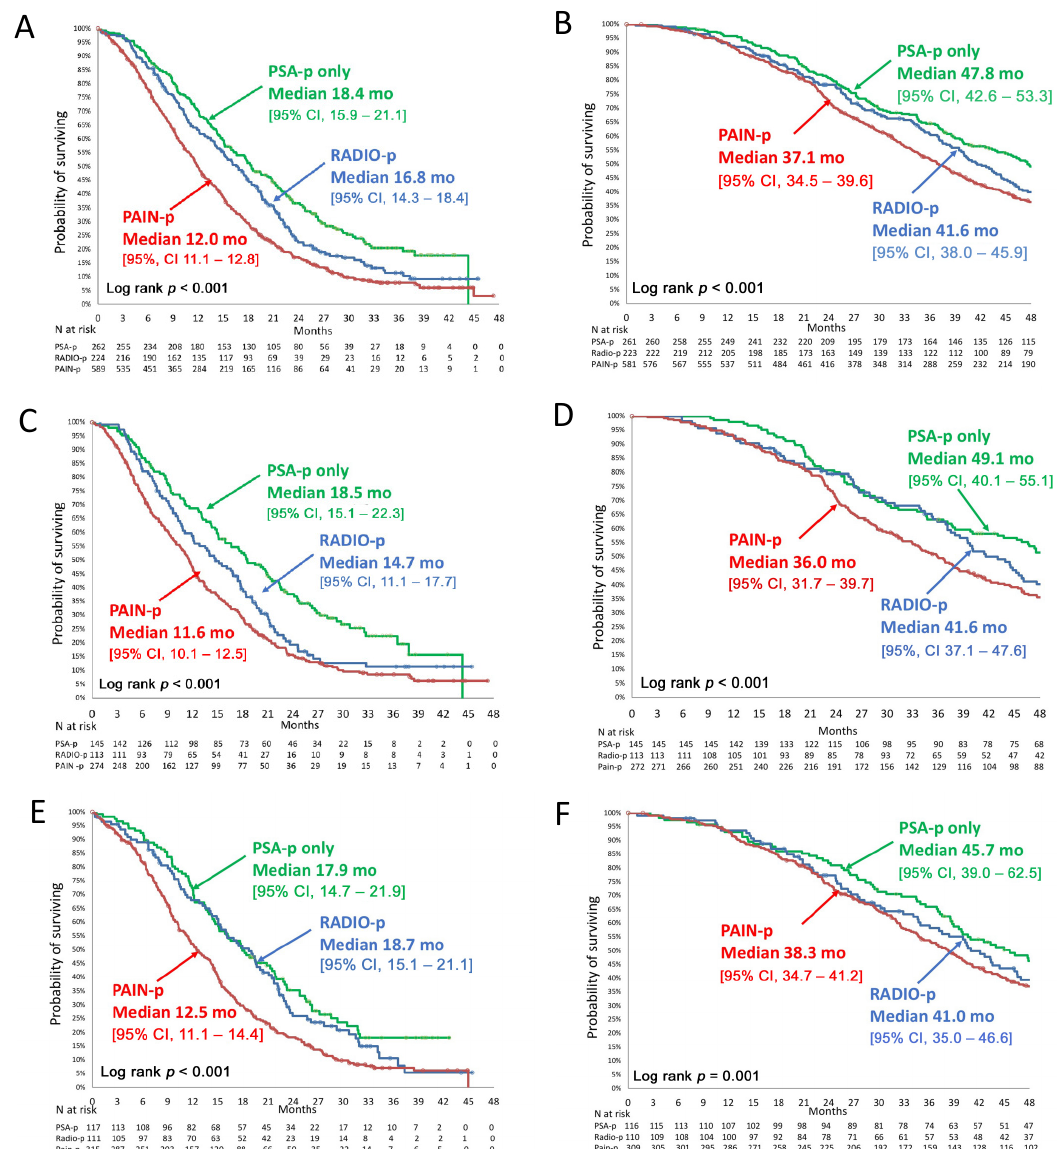
Figure 2. Overall survival according to the type of disease progression from date of cabazitaxel initiation and from date of mCRPC diagnosis. ( A ) Overall survival (OS) from cabazitaxel (CABA) initiation in ITT population all arms combined, ( B ) OS from date of mCRPC diagnosis all arms combined, ( C ) OS on CABA20 from CABA initiation, ( D ) OS on CABA20 from date of mCRPC diagnosis, ( E ) OS on CABA25 from CABA initiation, ( F ) OS on CABA25 from date of mCRPC diag- nosis. CABA20: cabazitaxel 20 mg/m 2 every 3 weeks (Q3W), CABA25: cabazitaxel 25 mg/m 2 Q3W, mCRPC: metastatic castration-resistant prostate cancer, ITT: intention to treat population, PSA-p: PSA progression only, RADIO-p: radiolog- ical progression (with or without PSA-p), PAIN-p: pain progression (with or without PSA-p or RADIO-p). To avoid a lead time bias, median OS was also calculated from date of mCRPC diag- nosis (Figure 2): median OS, all arms combined, was 37.1 (34.5 – 39.6) months in the PAIN-